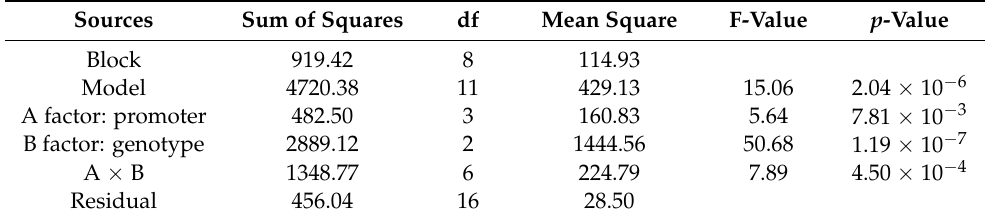
Table 1. Modeling statistical analysis of the mean blue value of RGB extracted from transgenic eucalyptus leaves by GUS histochemical staining. In the table, sources: variation sources; df: degree of freedom; and p -value: the probability of the same line item. If the p -value is less than 0.001, it indicates a significant difference at a level of 0.001. Block: different treatment groups; model: two-factor full factorial model; A × B: interaction of A factor (promoter) and B factor (genotype); and residual: residual error of the